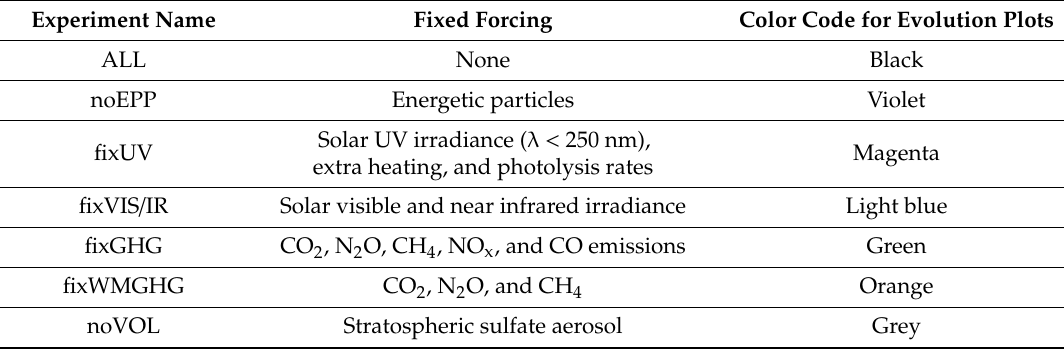
Table 1. The list of performed ensemble numerical